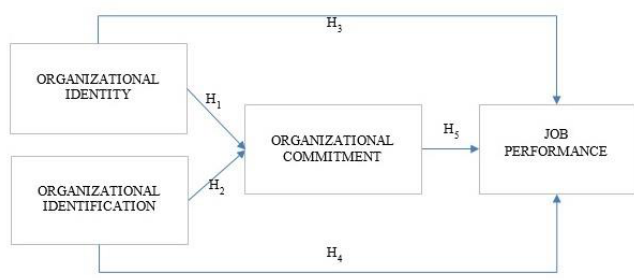
Figure 1. Conceptual